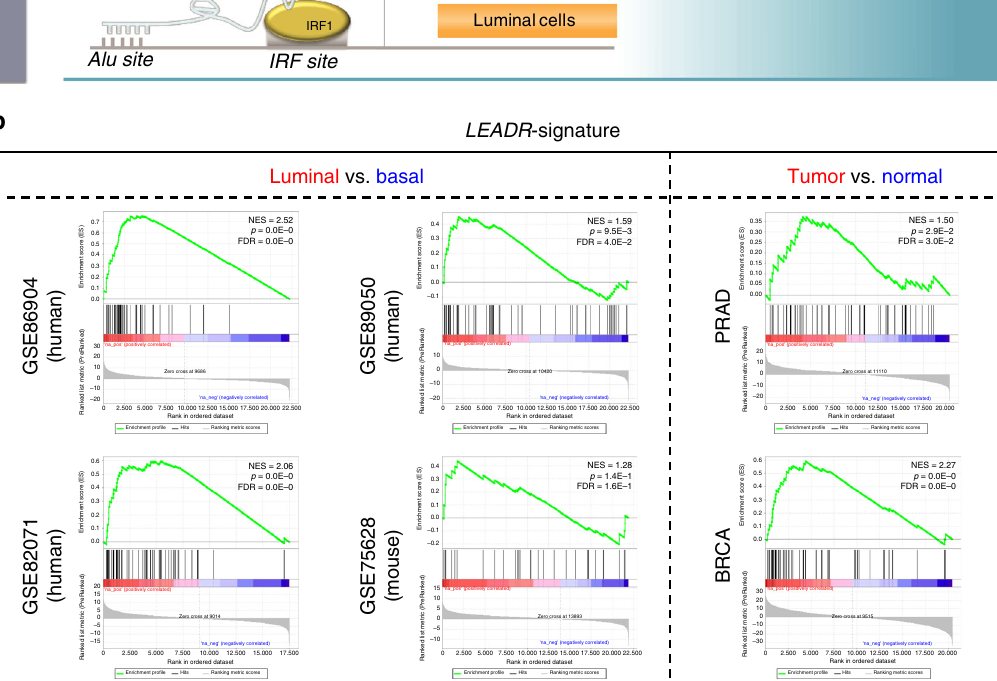
Fig. 10 Proposed model of LEADR function. a Schematic representation of biogenesis of miR-205 and LEADR -speci fi c transcripts from MIR205HG locus. The hypothetical model of action of LEADR as nuclear lincRNA capable of regulating basal – luminal differentiation is depicted. The speci fi c functions of miR-205 and LEADR in basal cells are reported on the right. b GSEA of “ LEADR -signature ” genes on GEO datasets of basal/luminal cells ( left ) and in tumor/normal tissues ( right ) from TCGA data (prostate, PRAD, and breast, BRCA, cancers). NES, p, and FDR values are indicated in each